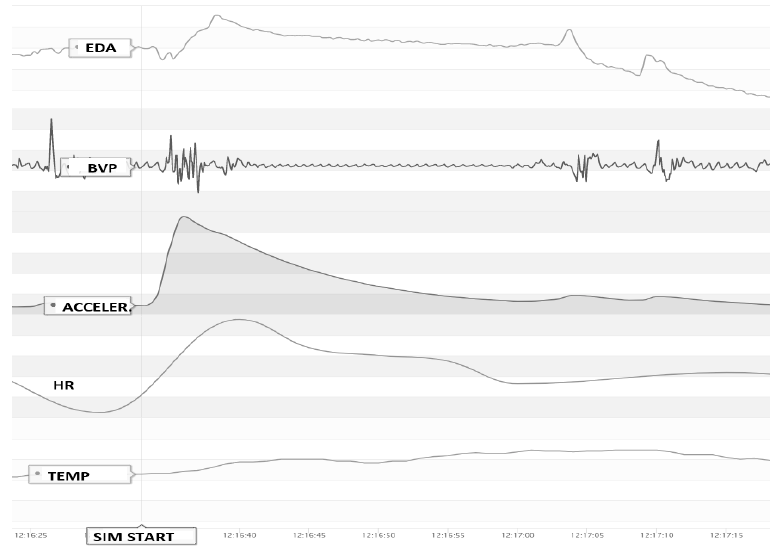
Figure 4. Biometric parameters when simulation starts. EDA—Electro-Dermal activity, BVP—Blood-Volume pulse, ACCELER—wrist acceleration, HR—Heart-Rate,